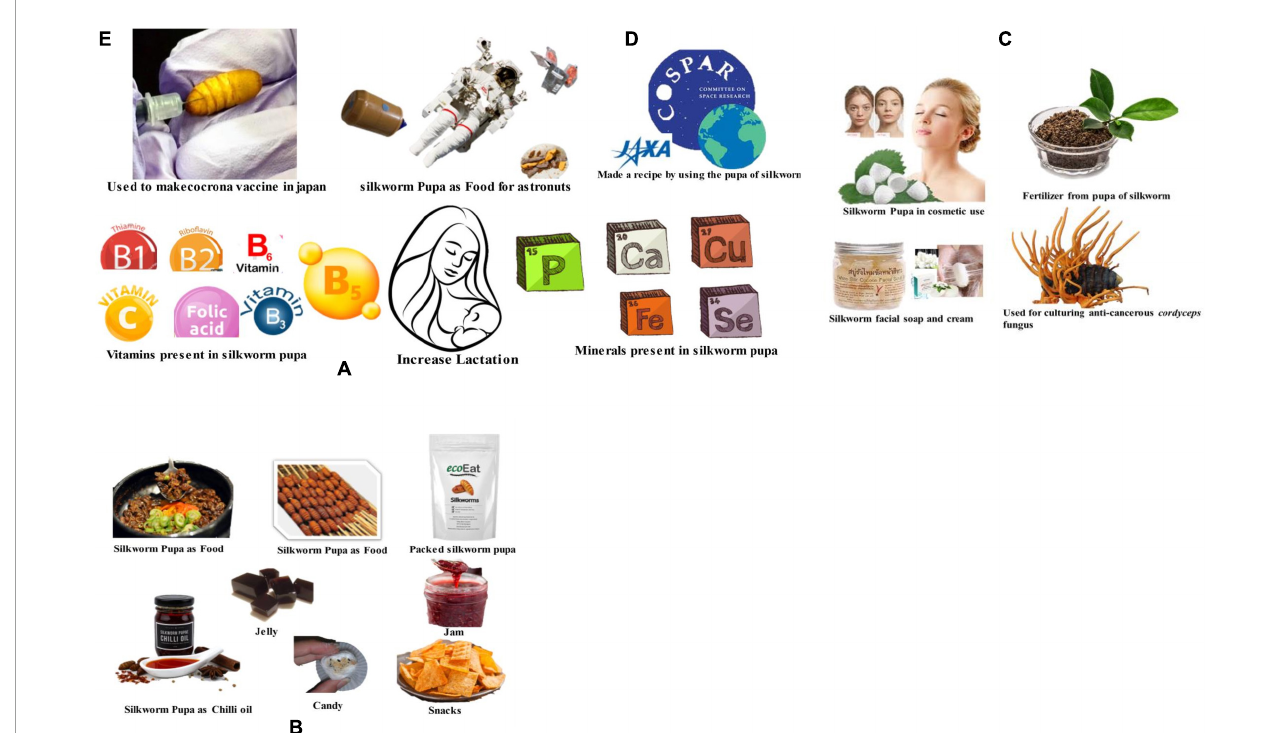
FIGURE6 Representing benefits of silkworm pupae industry (A) silkworm pupae contains several vitamins and important minerals those helps in increasing lactation for mother. (B) Representing silkworm pupae in food industry which is available in several forms like delicious cooked food, packed silkworm pupa, chili oil, candy, jelly, jam, snacks. (C) Silkworm used in cosmetics and chemical industry producing soap, cream, fertilizer. It is also used as culturing agent for cordyceps fungus (anti-cancerous). (D) Silkworm pupae used as food supplements in space for astronuts due to high protein content. (E) Silkworm pupae used for making vaccine for corona